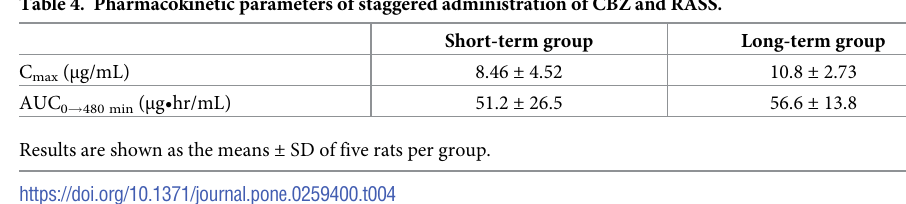
Table 4. Pharmacokinetic parameters of staggered administration of CBZ and RASS.